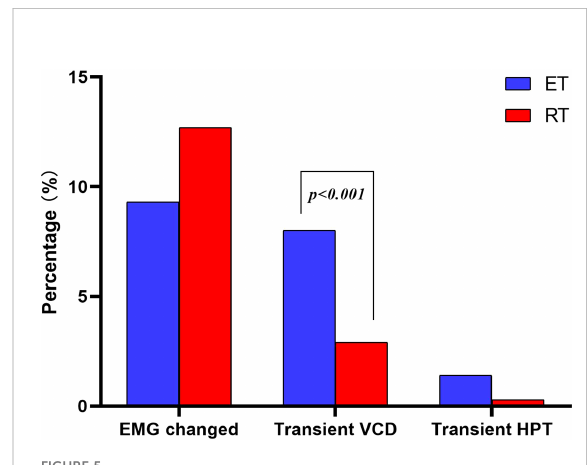
FIGURE 5 Comparison of postoperative complication between ET and